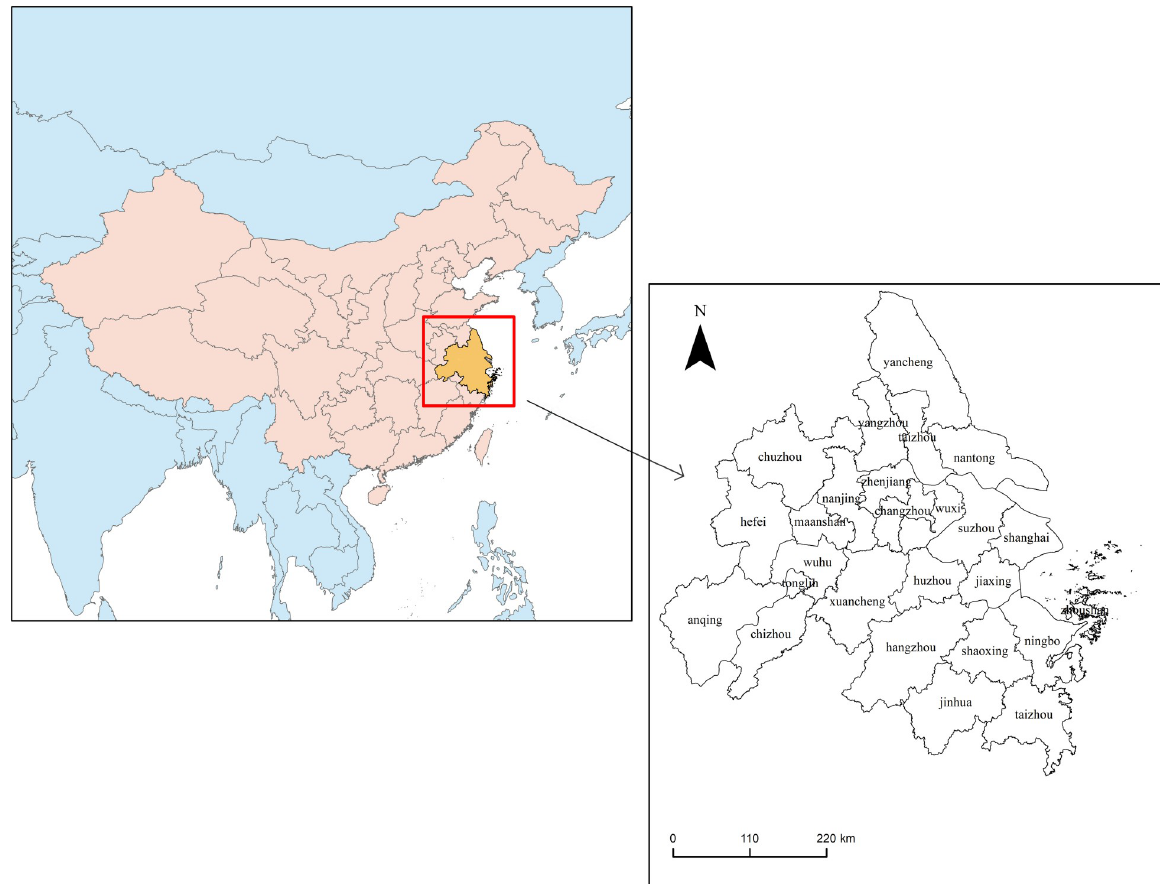
Fig 2. Location of 26 cities in the Yangtze River Delta. (The left frame is a part of the world map, in which the red and yellow parts belong to China, and the yellow part is the study area. The right frame is to enlarge the yellow area of 26 cities in the Yangtze River Delta. The data come from publicly available data on the internet and are organized by the authors themselves. The figure is drawn by Arc GIS).